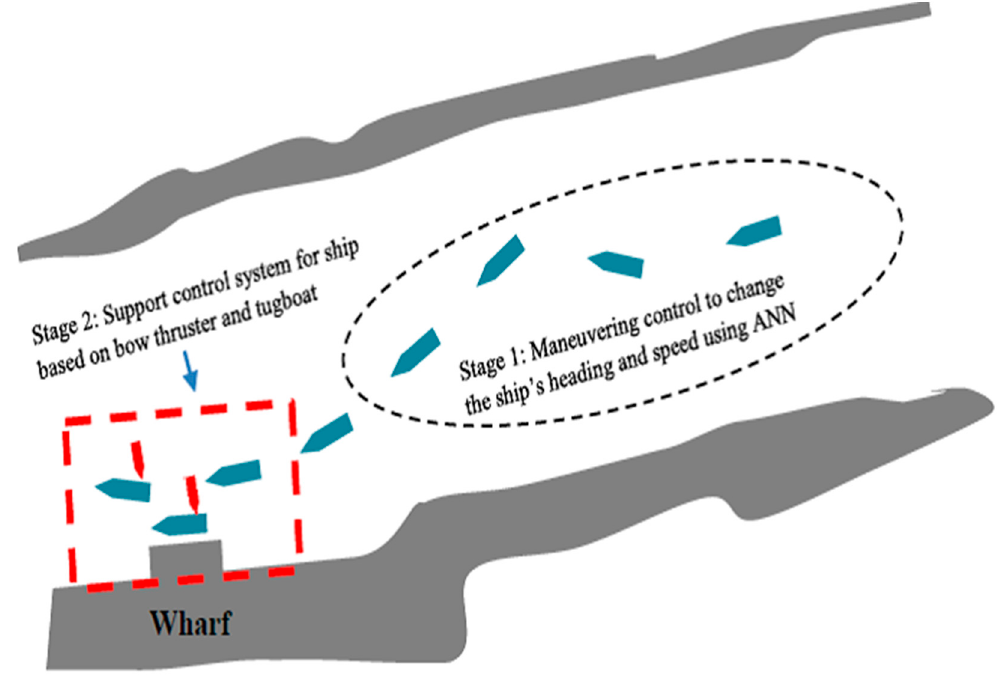
Figure 2. Two stages in the berthing process of a marine ship.